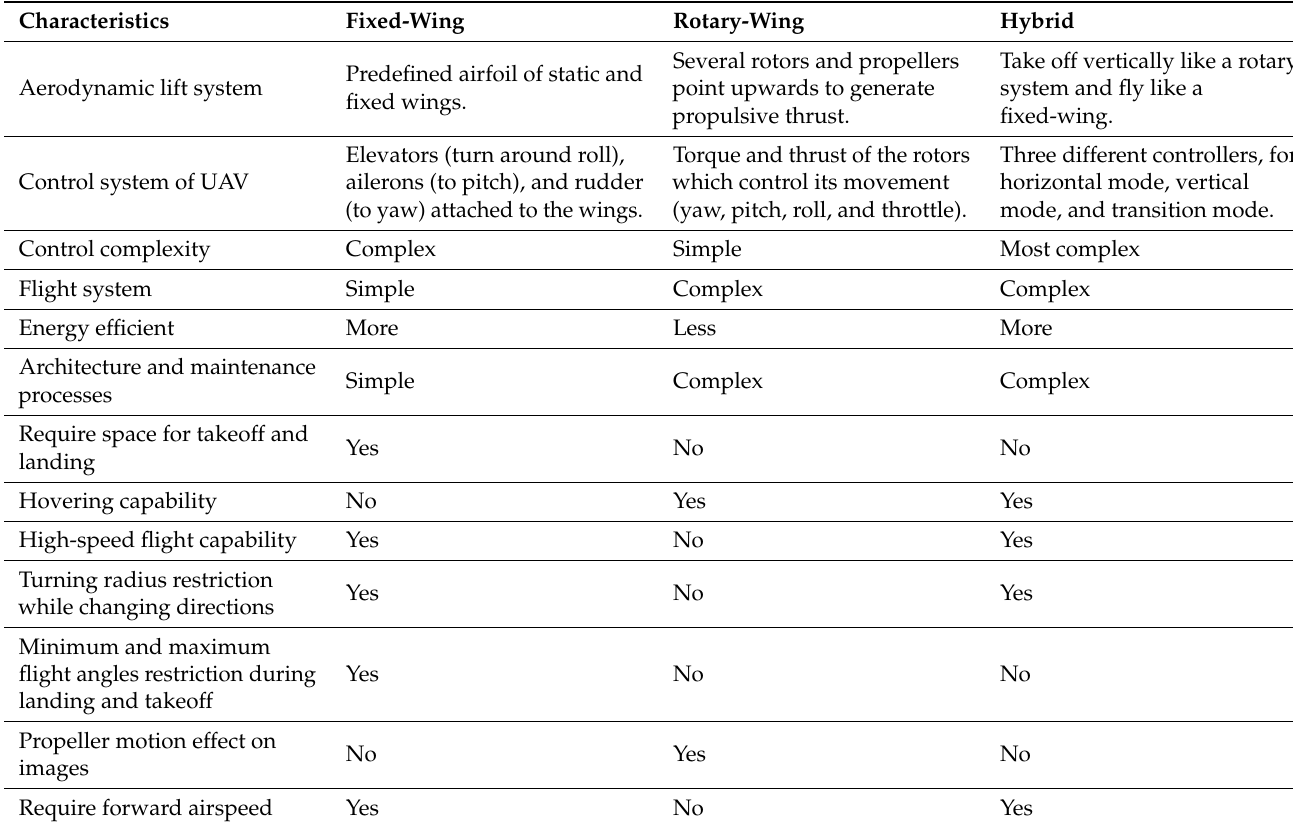
Table 3. Frequently used UAVs types and their technical characteristics.